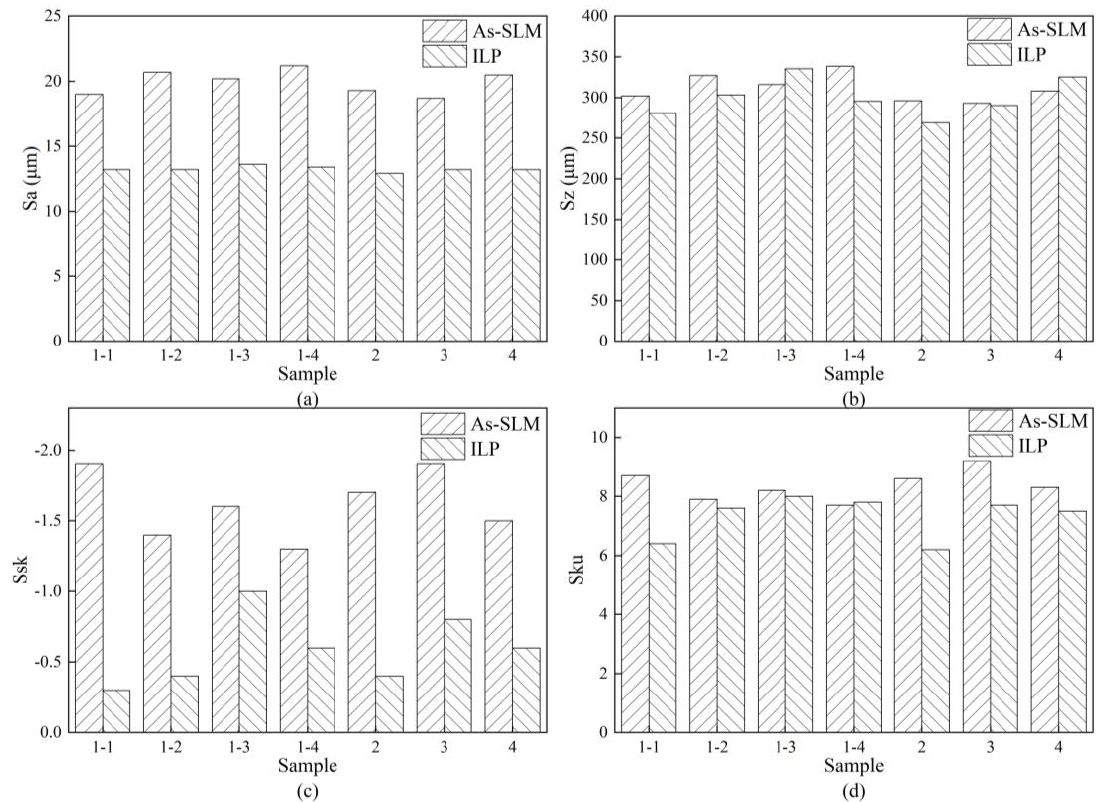
Figure 2. Surface roughness data. ( a ) Sa; ( b ) Sz; ( c ) Ssk; ( d ) Sku. The parameters of SLM were 185 W, 0.6 m/s and 0.05 mm and 0.01mm (power, speed, spot diameter and hatch spacing). The parameters of ILP were 180 W, 0.6 m/s and 0.05 mm and 0.01mm (power, speed, spot diameter and hatch